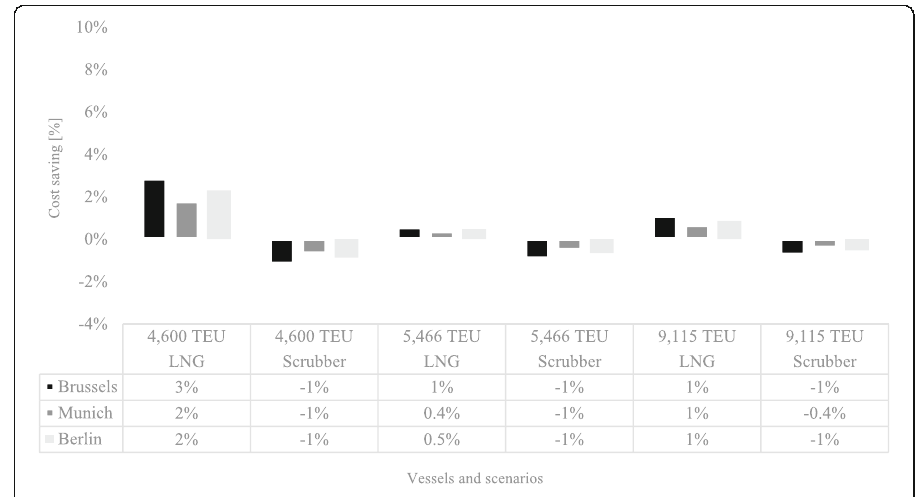
Fig. 10 Relative changes for supply chain cost from Jacksonville to EU for different ship types and for LNG and scrubber scenarios (by increasing the price of LNG and decreasing price of